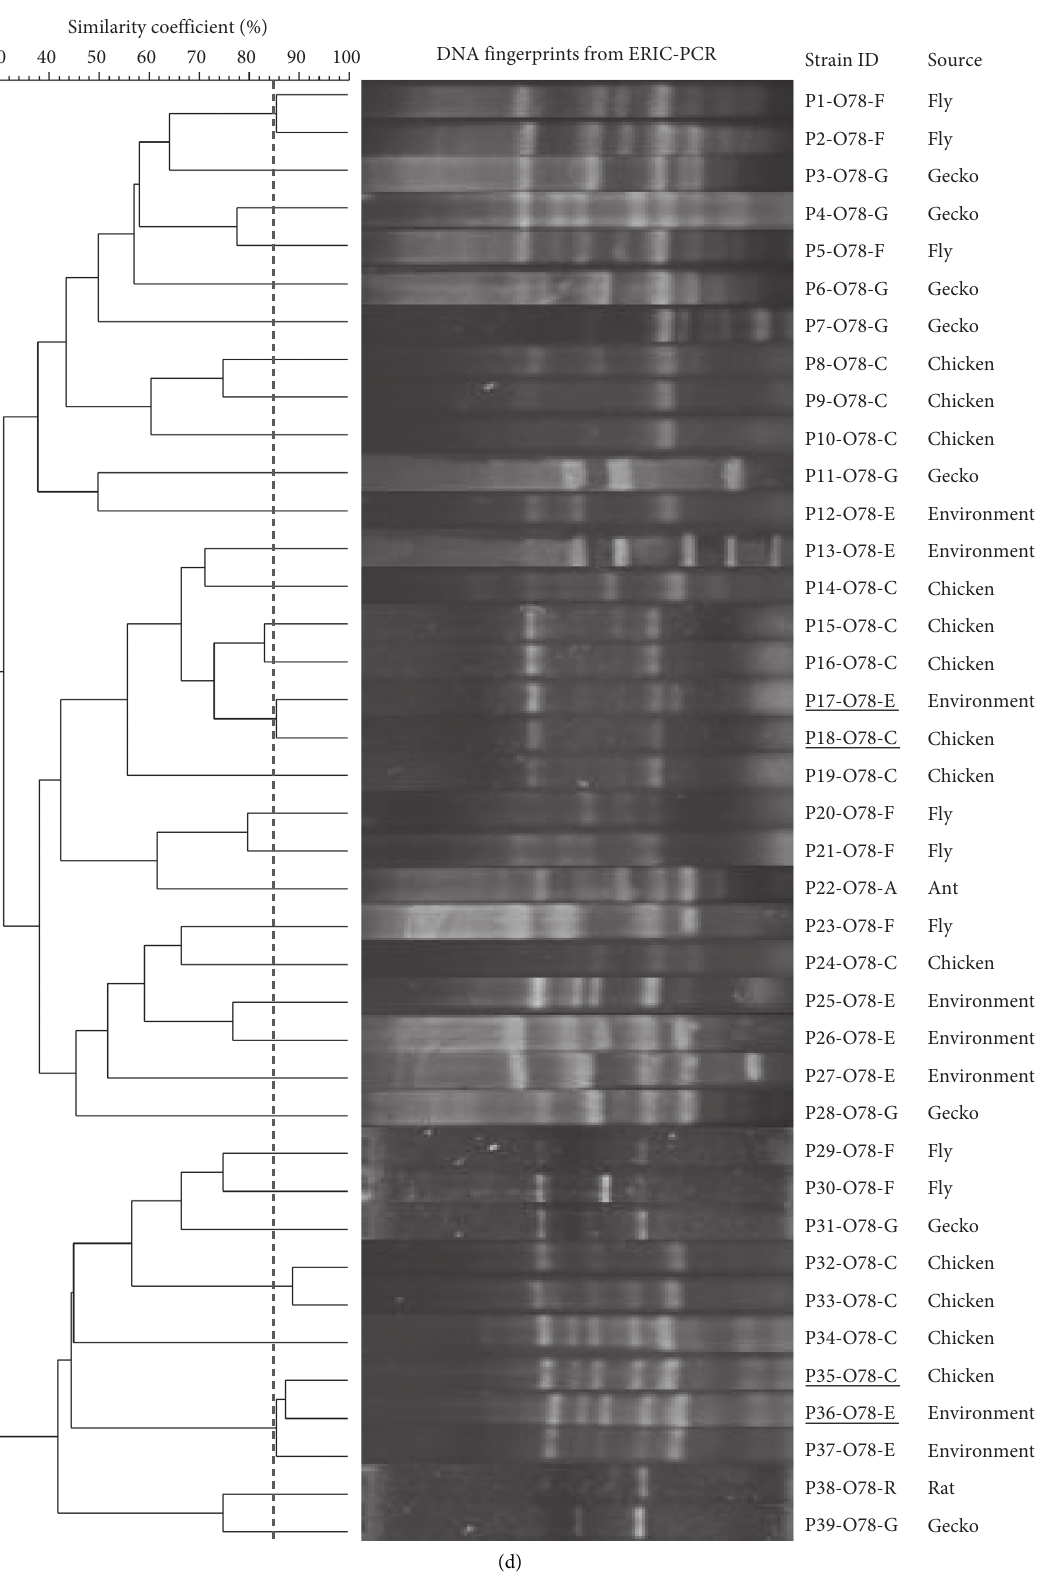
Figure 3: Dendrograms and genomic DNA fingerprints of E. coli isolates that belong to the O1 (a), O2 (b), O18 (c), and O78 (d). The results were produced from ERIC-PCR and Bionumerics software version 7.0. The dashed vertical line indicates the cutoff value ≥ 85% genetic similarity coefficient. E. coli strains that were isolated from different sample sources and shared ≥ 85% genetic similarity coefficient were